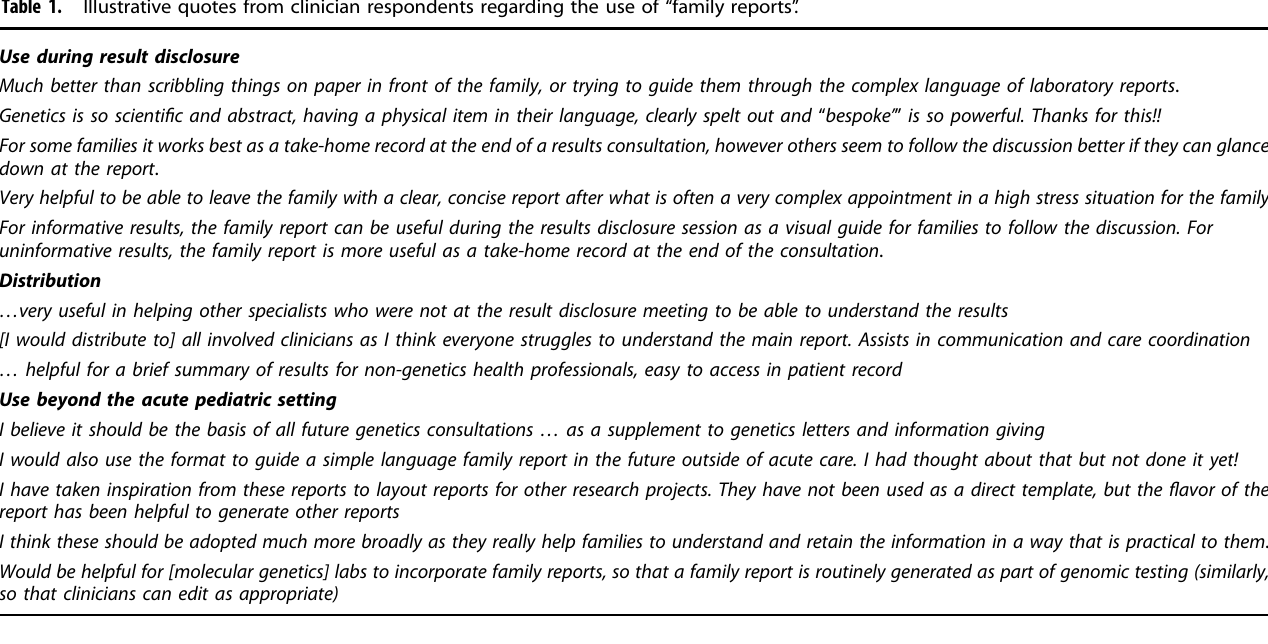
Table 1. Illustrative quotes from clinician respondents regarding the use of “ family reports ”